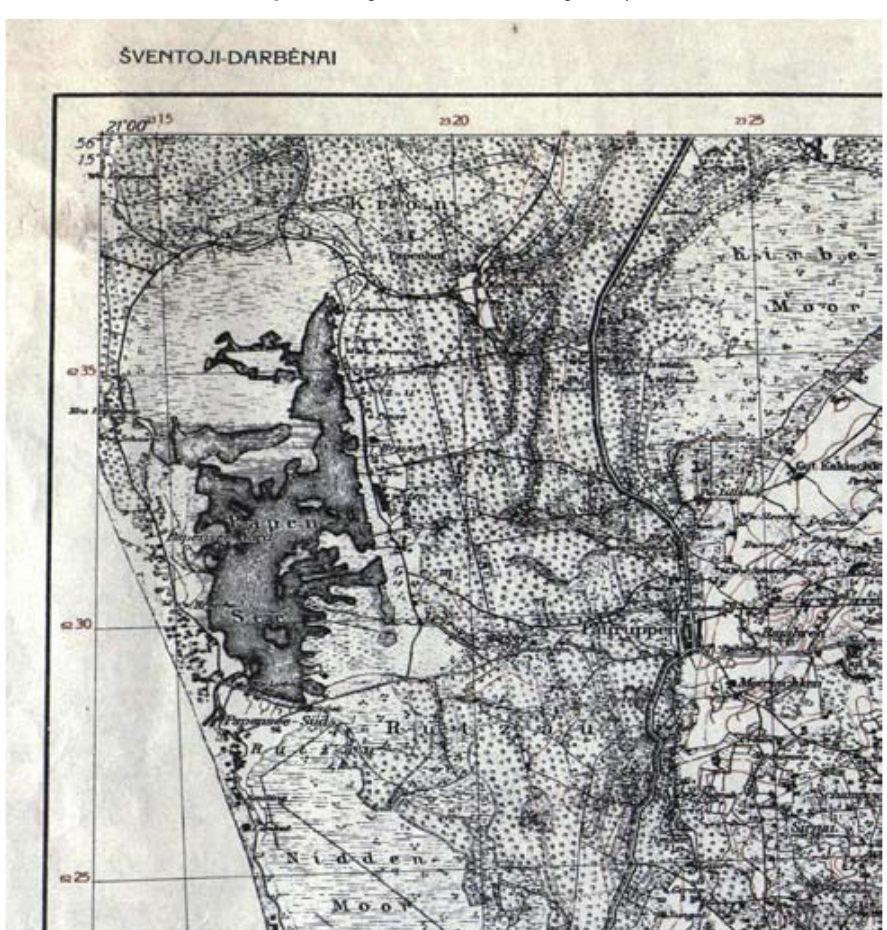
Fig. 2. Fragment of topographic map ŠVENTOJI – DARBėNAI, scale 1:100